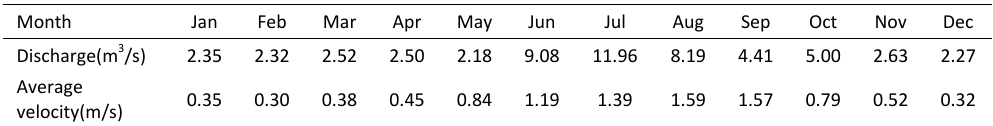
Table 3. Hydrologic parameters of Acheng District Section in Ashe River Table 3: Hydrologic parameters of Acheng District Section in Ashe